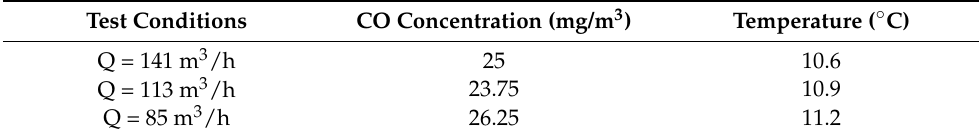
Table 5. Initial conditions for ventilation dilution